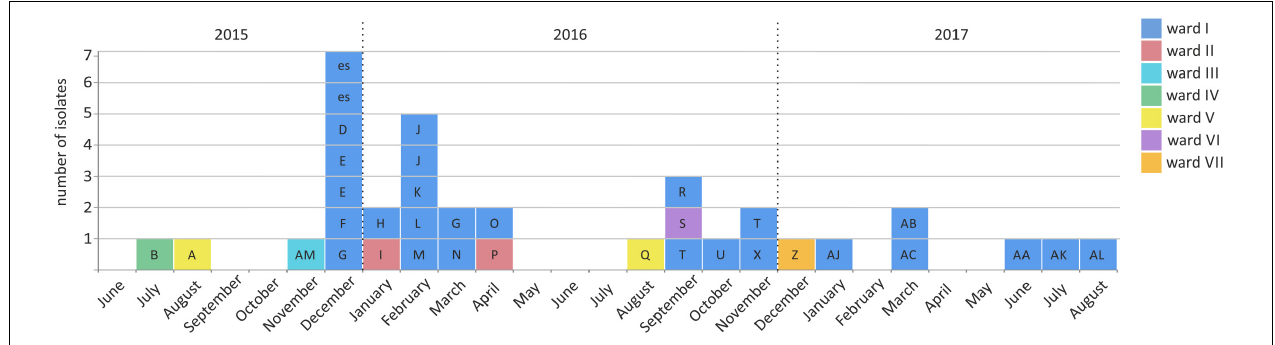
FIGURE 2 | Emergence of NDM-1-producing Enterobacterales between July 2015 and October 2017 in a German hospital. In total, 35 NDM-1 producing Enterobacterales isolates have been collected from 29 patients (indicated by capital box letters) and two environmental samples (labeled as “es”) across different wards (indicated by box